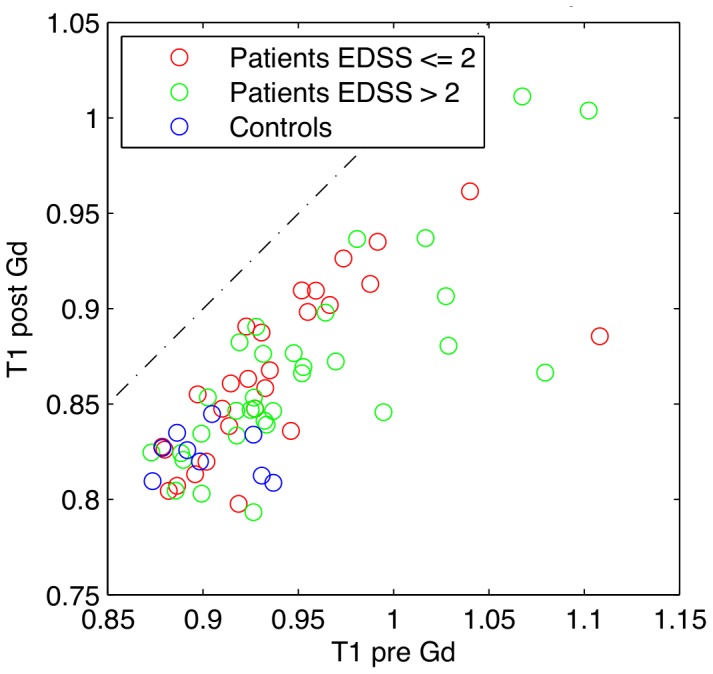
T1 values before and after the injection of contrast agent.For each healthy control and each patient, the mean T1 of the white matter and NAWM, respectively was calculated. Each subject is thus represented by a marker in the corresponding position. All individual subjects had lower T1 values after the injection of contrast agent (i.e. all markers are plotted below the line representing y = x).